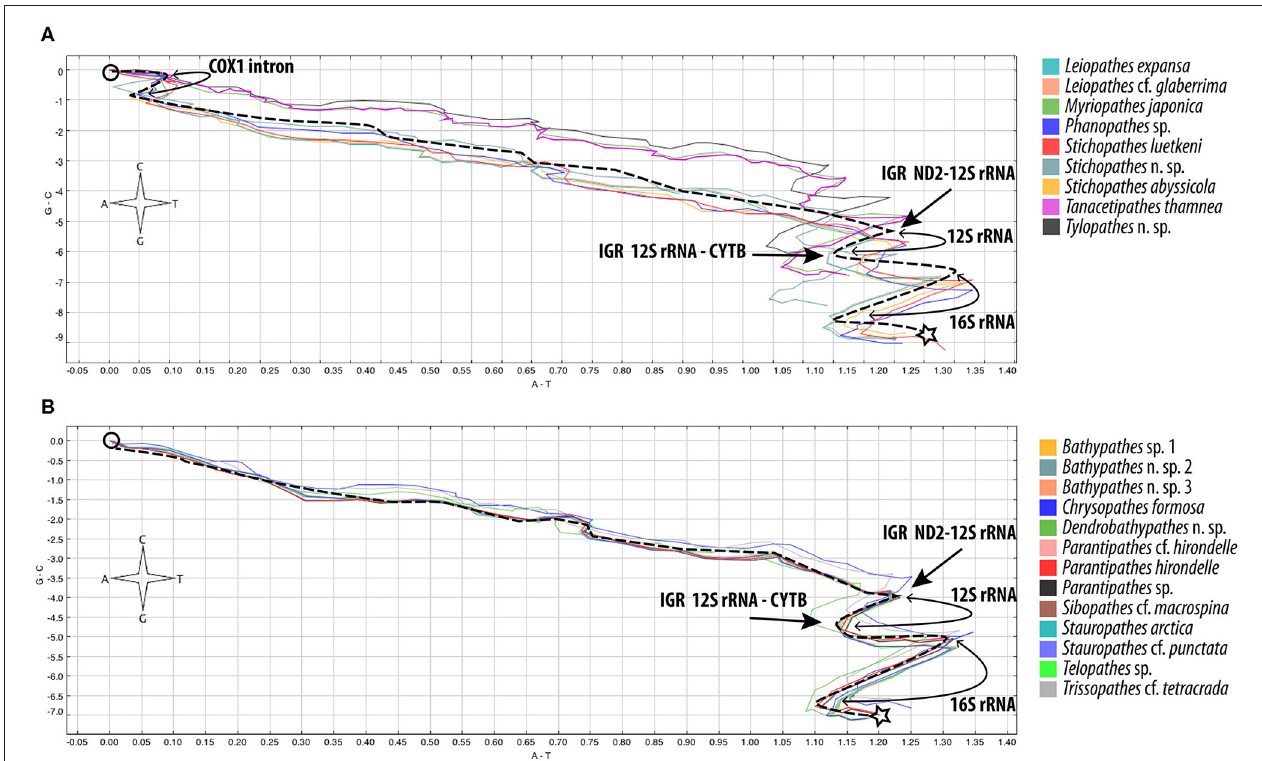
FIGURE 2 | DNA Walk [GraphDNA (Thomas et al., 2007)] results from vectorial representation of a linearized genome beginning at COX1 (circular symbol) and ending at IGR COX3-COX1 (star symbol). Each of the four nucleotides in the genome sequence is designated a direction as displayed on the compass. Units on axis are cumulative skew measured as number of nucleotides X 10 3 (Window size is displayed at 400 for ease of viewing). (A) Genomes with the COX1 intron. (B) Genomes with the COX1 intron absent. The dotted line represents the general shape of the walk. Abrupt changes in direction are characteristic of a separate evolutionary origin for that particular